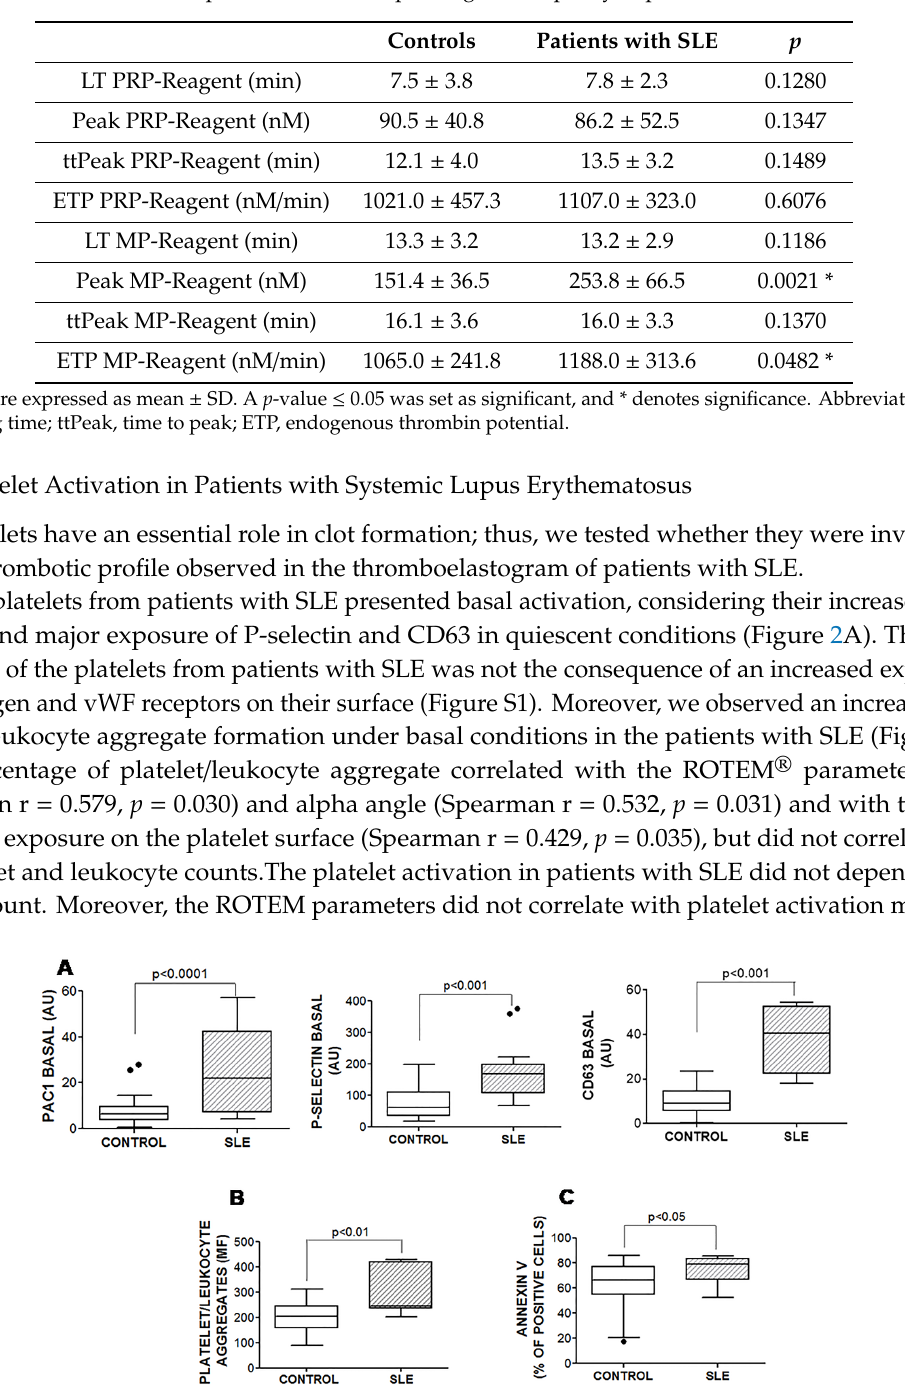
Table 3. Microparticle-associated procoagulant capacity in patients with SLE.